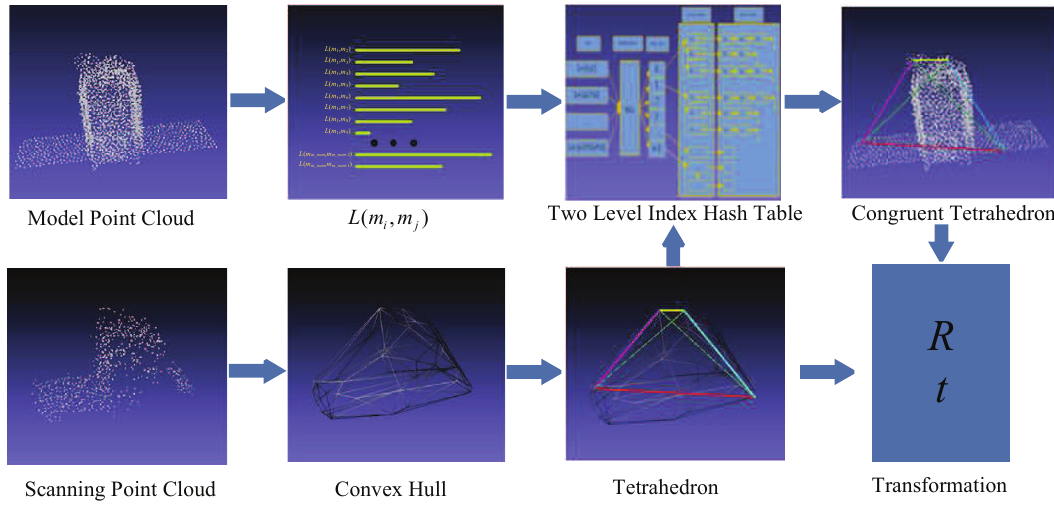
Figure 3. Flow of CTA